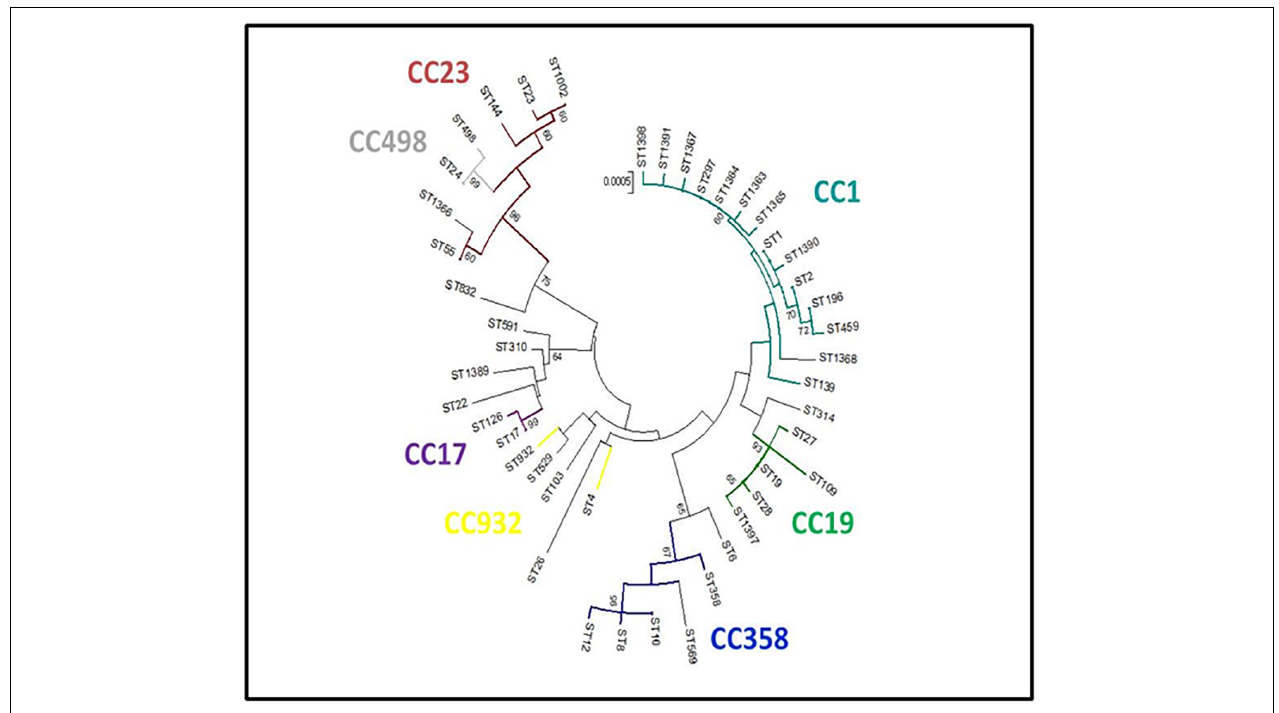
FIGURE 3 | Neighbor-joining (NJ) tree. Genetic relationships among the 45 S. agalactiae sequence types (STs) obtained in the present study were inferred with MEGA5 software [14]. Evolutionary distances were calculated using the p -distance method, which considers the number of different nucleotides out of the total (3,456). A NJ tree with 1,000 bootstrap replications was constructed. The clonal complexes (CCs) obtained by the global eBURST analysis are reported.